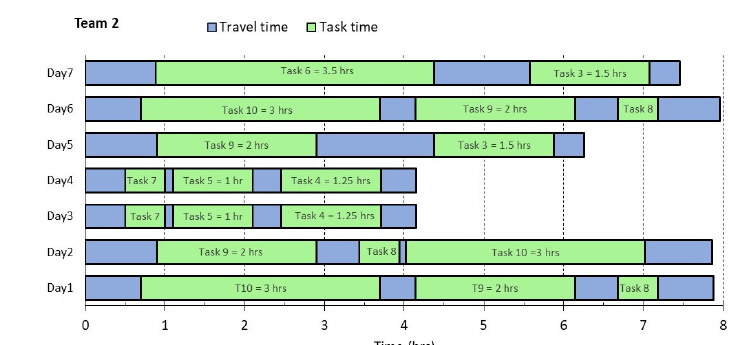
Fig. 5- b . The schedule of team 2 at a speed of 5 km/hr (efficiency =81.78%).